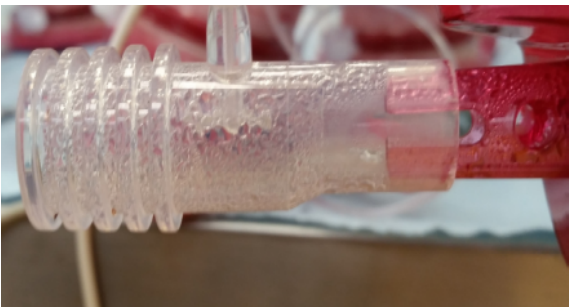
Figure 6. Effect of water vapor condensation on a test cuvette placed at the exhaust port of a membrane oxygenator.